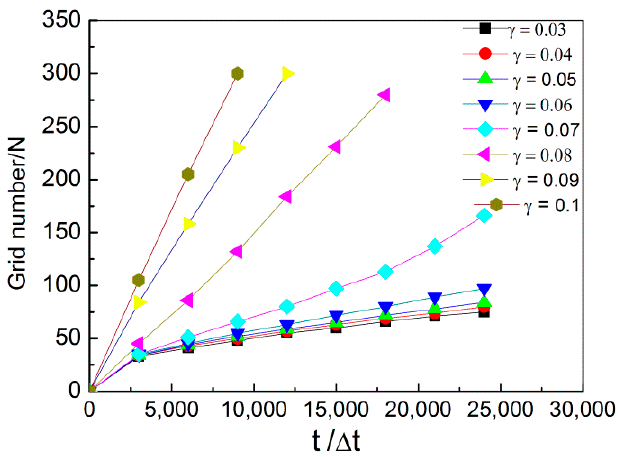
Figure 5. The tip grid positions of crystals with different anisotropy coefficients.